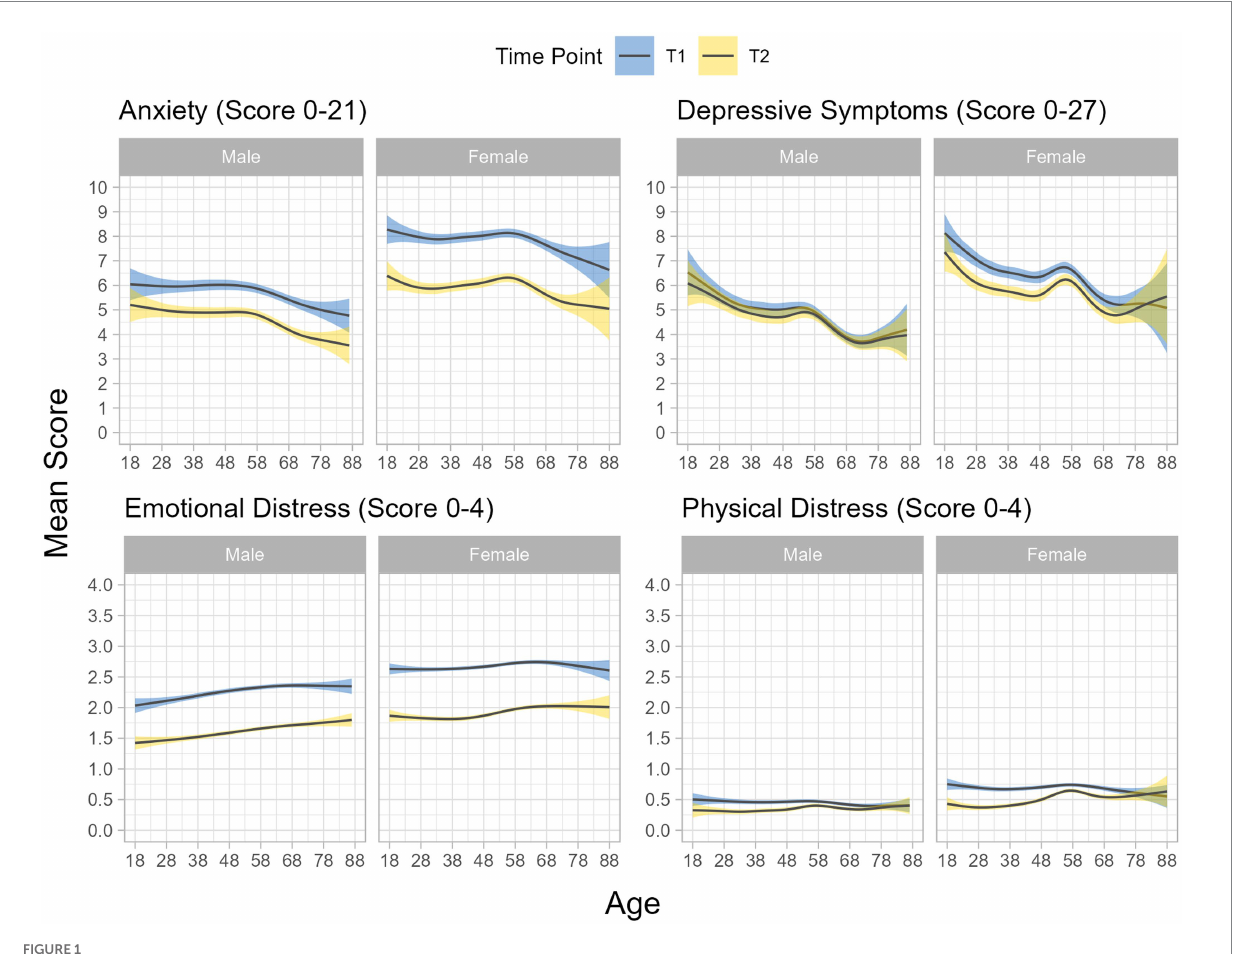
FIGURE 1 Average value of mental health indicators by age and sex * at the start of the war (T1) and 6 month later (T2). Figures are obtained by ggplot, applying the gam function with splines in mgcv library. * due to group size, analysis by age was only carried out for male and female